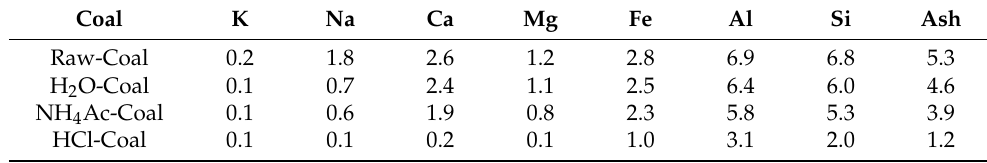
Table 3. Content of mineral elements in CFA